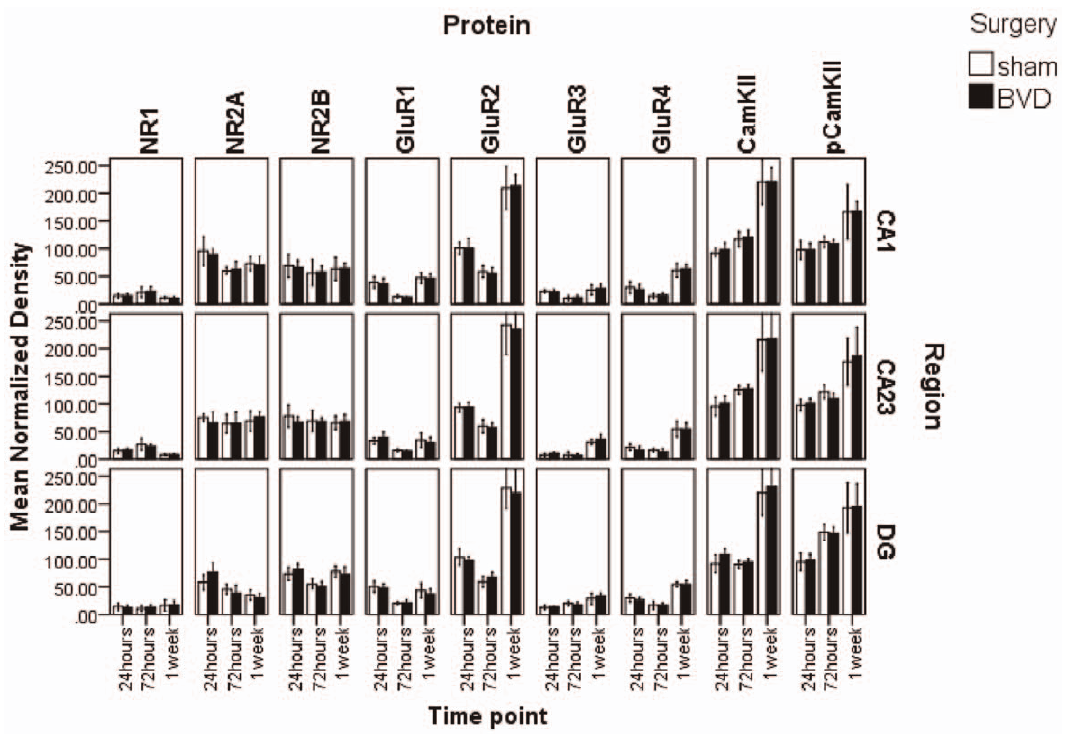
Figure 1. Mean normalized density of expression of NR1, NR2A, NR2B, GluR1, GluR2, GluR3, GluR4, CaMKII a and pCaMKII a in the CA1, CA2/3 and DG regions of the hippocampus at 24 h, 72 h and 1 week following BVD or sham surgery. Error bars represent 95% confidence intervals for the mean.